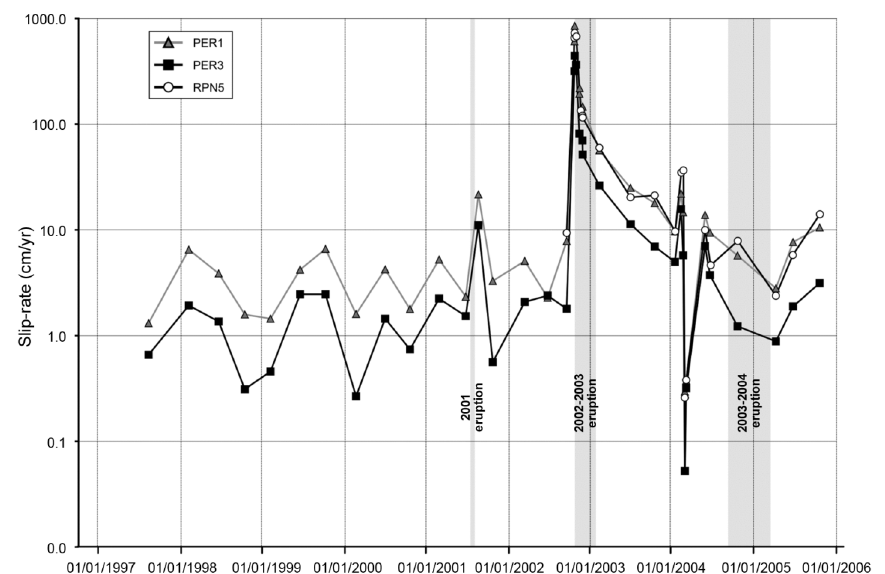
Fig. 6. Time evolution of the slip-rates of some selected GPS benchmarks. Y -axis is in logarithmic